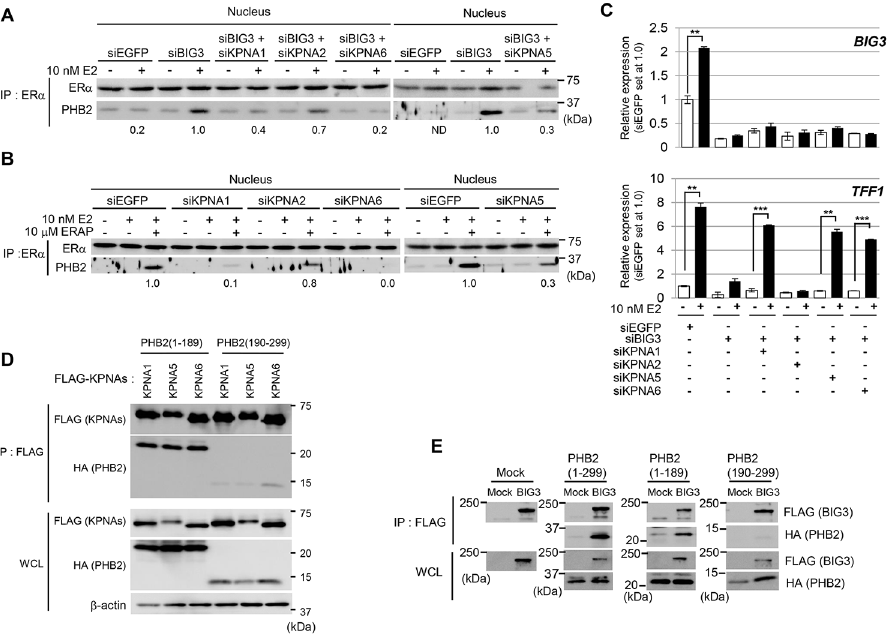
Fig 5. KPNA1, KPNA5, and KPNA6 induce E2-dependent nuclear translocation of PHB2. (A) Immunoblotting analysis was performed to evaluate the interactions between ER α and PHB2 in BIG3- and KPNA (KPNA1, KPNA5, and KPNA6)-depleted MCF-7 cells. MCF-7 cells were treated with siBIG3 and each siKPNA, followed by E2 ± ERAP for 24 h. Then, the nuclear fractions were immunoprecipitated with anti-ER α antibody and were immunoblotted with antibodies against the indicated proteins. The data are expressed the fold increase over E2-treated siBIG3-transfected cells of right and left panels, respectively (set at 1.0). ND: not detected. This experiment was performed using the nuclear fractions used in Fig 3A; (B) The interaction between ER α and PHB2 released by E2 and ERAP in the nuclear fractions was evaluated. MCF-7 cells depleted of each KPNA were treated with E2 ± ERAP for 24 h, and the nuclear fractions were immunoprecipitated with anti-ER α antibody. The data are expressed the fold increase over E2-treated siEGFP-transfected cells of right and left panels, respectively (set at 1.0). This experiment was performed using the nuclear fractions used in Fig 3B; (C) The TFF1 expression levels following treatment with siBIG3 and siKPNA were evaluated using real-time PCR. The data are expressed as the fold increase over the untreated cells (set at 1.0) and represent the means ± SD of two independent experiments ( ** P < 0.01, *** P < 0.001 in a two-sided Student ’ s t -test); (D) Immunoblotting analysis was performed to identify the KPNA-binding regions in PHB2. The lysates from COS-7 cells transfected with the indicated HA-PHB2 constructs and FLAG-KPNAs were immunoprecipitated with an anti-FLAG antibody; (E) Immunoblotting analysis was performed to identify the BIG3-binding region in PHB2. The lysates from HEK293T cells transfected with the indicated HA-PHB2 constructs and FLAG-BIG3 were immunoprecipitated with an anti- FLAG antibody. Full-length images of immunoblots are shown in S6A – S6D